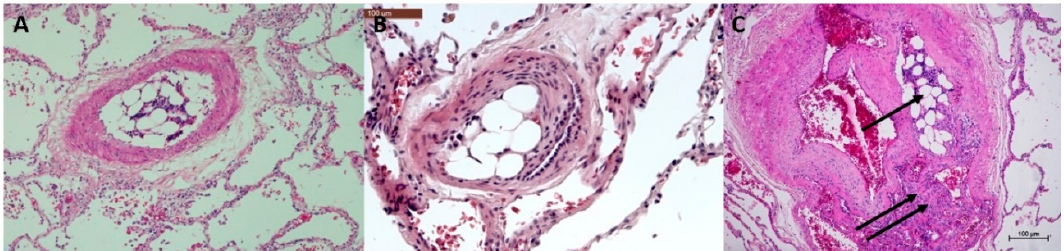
Figure 11. Histopathology of non-fibrinous embolic specimen in humans. ( A ) Occlusive embolic specimen of bone marrow without angiophagy. ( B ) Stage II angiophagy of a bone marrow embolic specimen. ( C ) Stage II angiophagy of a bone marrow embolic specimen (single arrow) and of a cellularized fibrinous thrombus (double arrow). Stain is hematein–eosin–saffron.